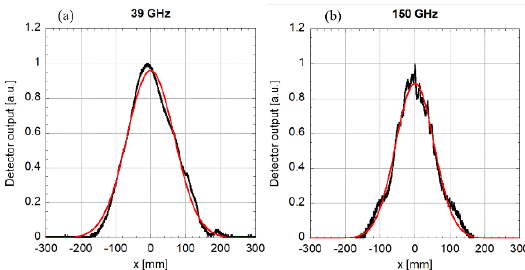
Fig. 5. Beam profiles at 1.5 m from the M1 mirror for (a) 39 GHz and (b) 150 GHz millimeter waves. Black lines are measurements, red lines are Gaussian fits. Intensities are normalized to the maximum of the measured values.